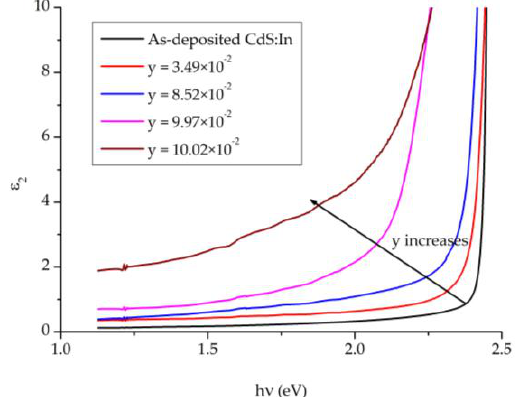
Figure 13. The imaginary part of the dielectric constant of a CdS:In thin film and CdS 1−y Te y thin films of different composition but comparable thickness.